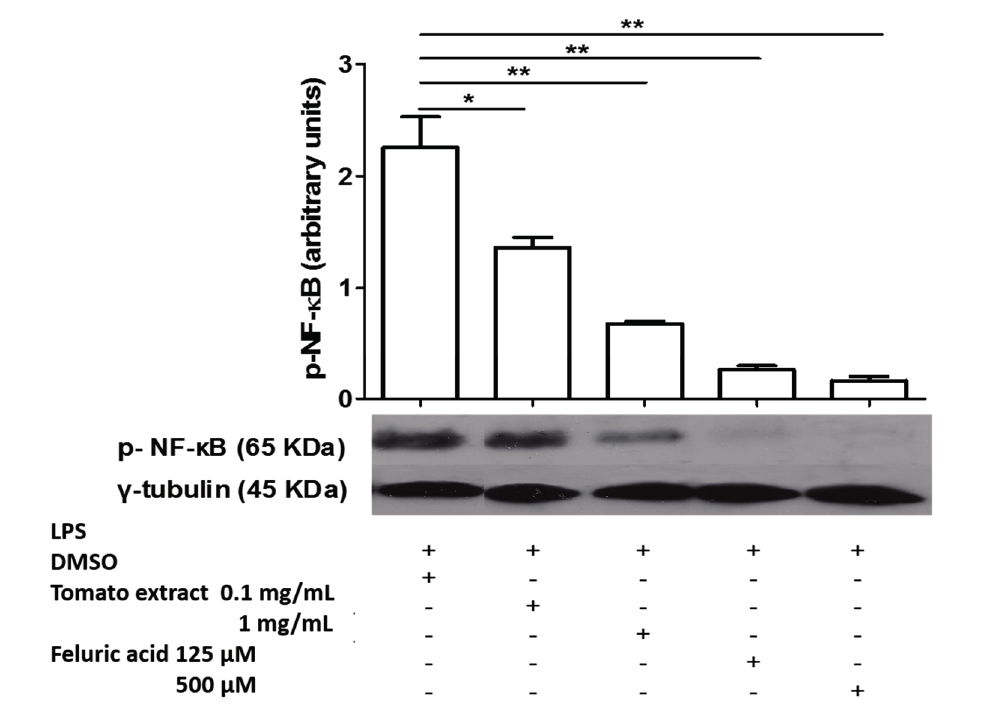
Figure 4. Extract tomato and Ferulic Acid inhibit the activation of NF- κ B in LPS-activated macrophages. LPS, lipopolysaccharide; DMSO, dimethylsulfoxide, * significant at the p < 0.05 level, ** significant at the p < 0.01